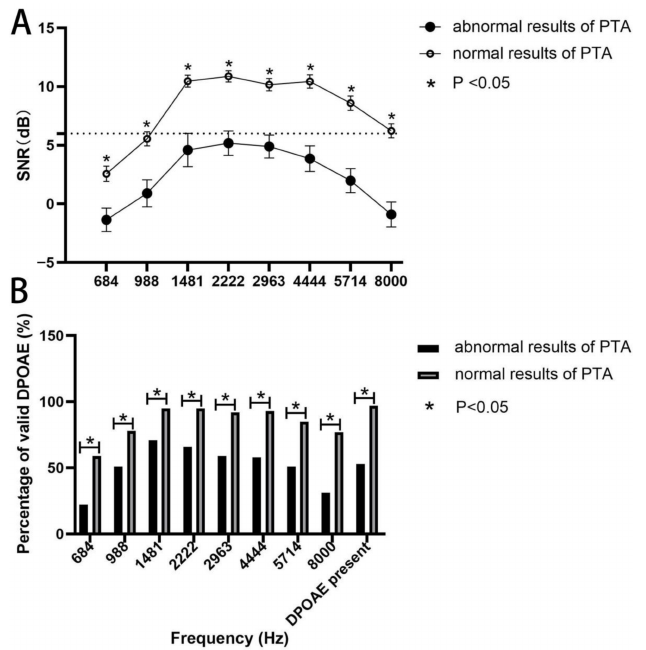
Figure 3. Association of DPOAE results with PTA. ( A ) SNR values in the ears of SLE patients with and without normal PTA at different frequencies. The dashed line indicates normal SNR value (6 dB). Data are presented as mean ± SEM and the mean values at each F2 frequency are linked by the trend line. p < 0.05 by t -test. ( B ) Percentages of valid DPOAE in the ears of SLE patients with and without normal PTA at different frequencies. p < 0.05 by chi-squared test. DPOAE: distortion product otoacoustic emission; PTA: pure tone audiometry; SNR: signal-to-noise